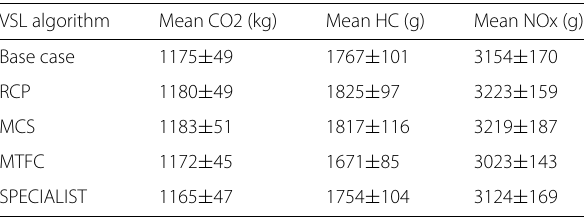
Table 1 Environmental impacts for the base case and the VSL